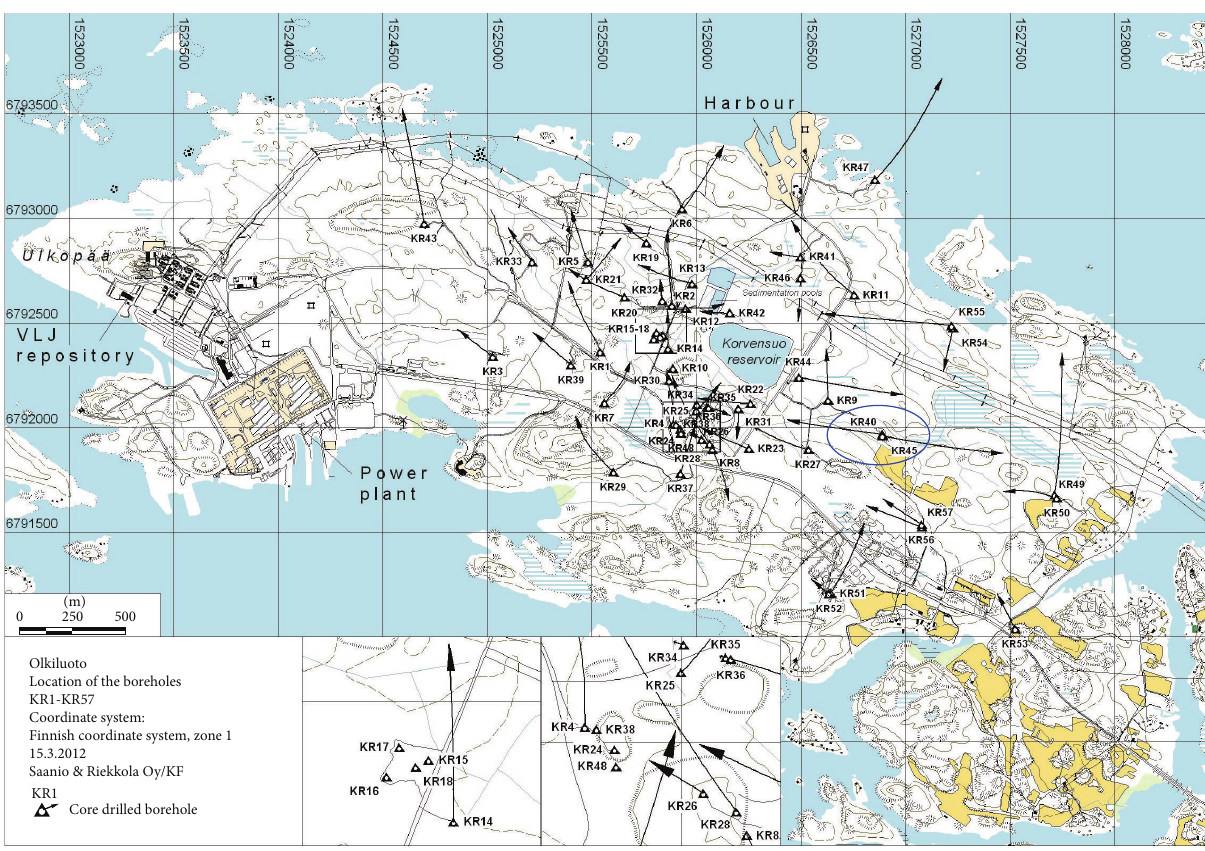
Figure 7: The map of Olkiluoto site. The borehole pair (OL-KR40–OL-KR45) is marked by an oval.